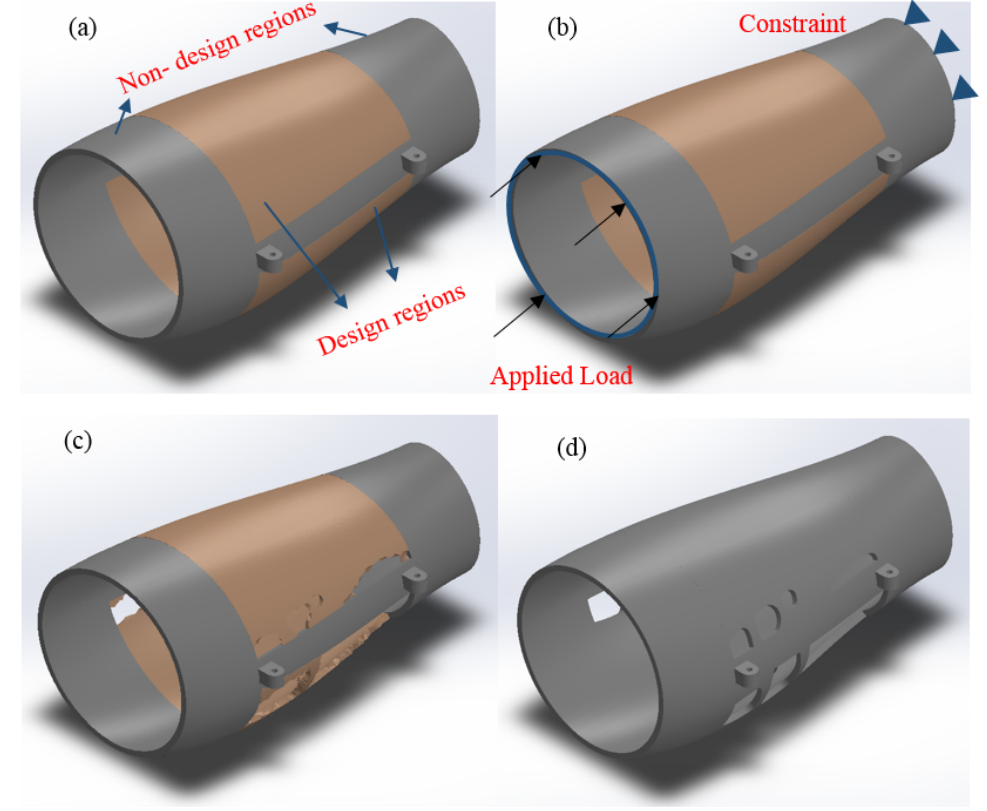
Figure 5. ( a ) Solid design, ( b ) loading and boundary conditions, ( c ) initial topology design and ( d ) final topology design.